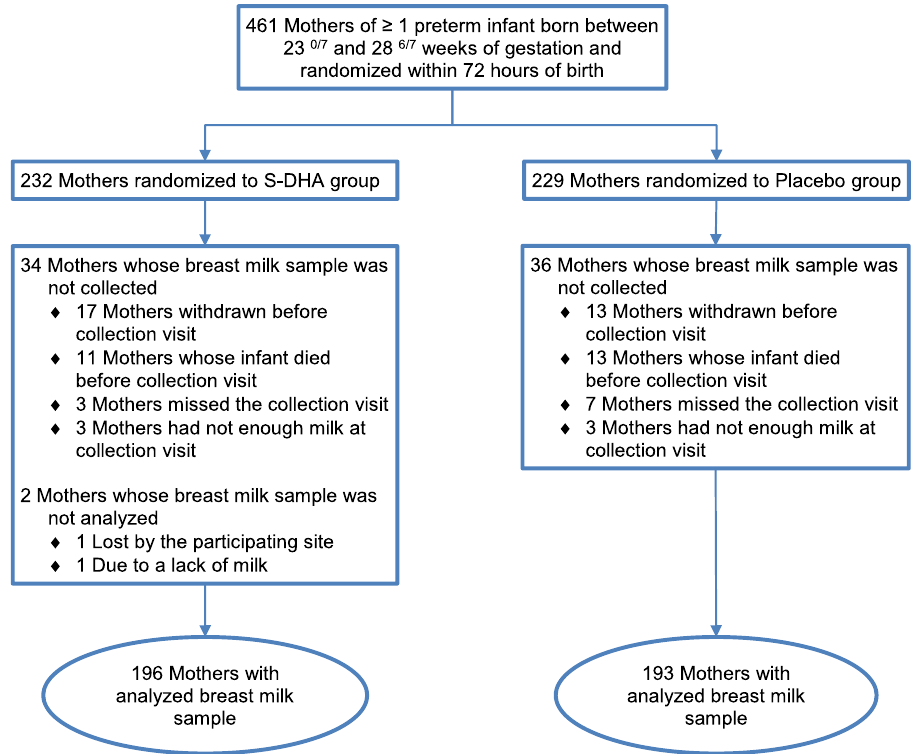
Figure 1. Trial flow diagram of mothers in the group supplemented in DHA (S-DHA) and the placebo group.